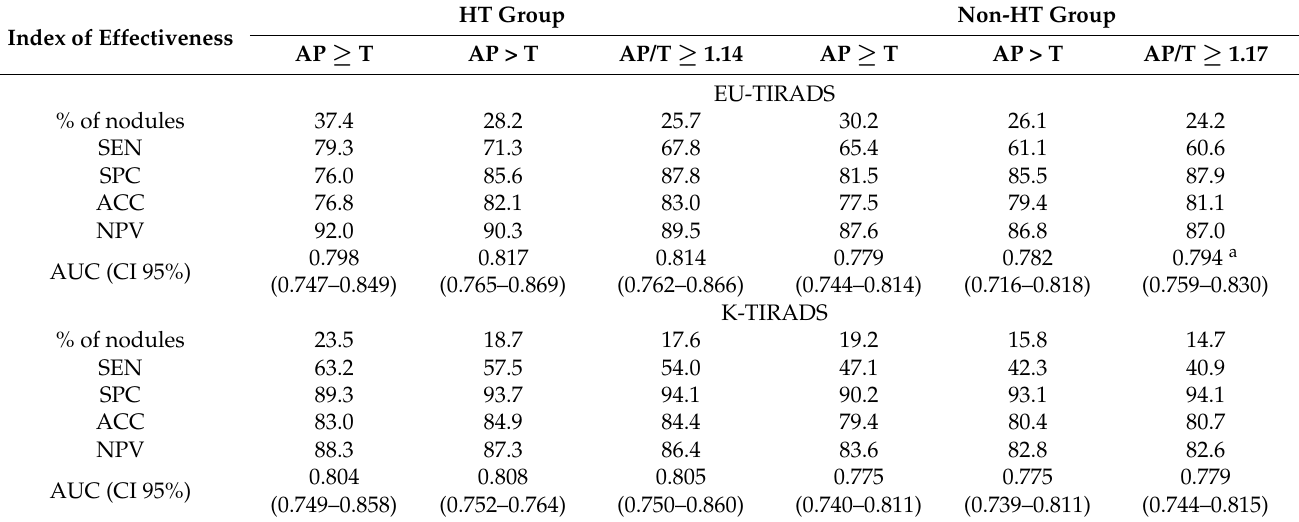
Table 4. Data on the diagnostic effectiveness of analyzed SRSs in HT and non-HT groups for the high risk category (nodule’s shape evaluated on the transverse